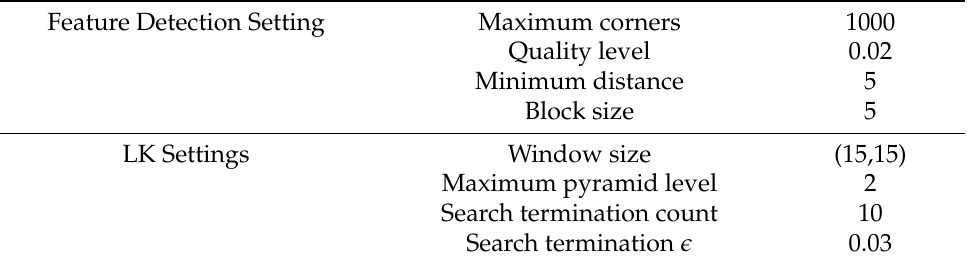
Figure 4. A technique to re-scale from 14 bit to 8 bit images based on max and min pixel intensities [63]. Table 3. Settings parameters for LK technique and Shi–Tomasi corner detection algorithm